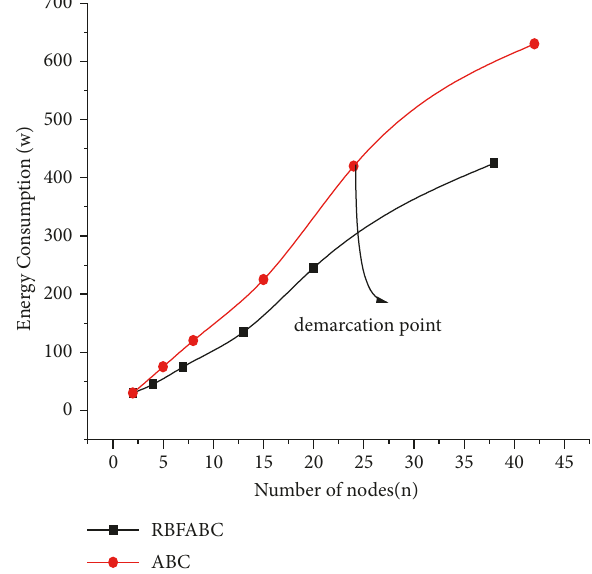
Figure 3: Power consumption diagram corresponding to different nodes.